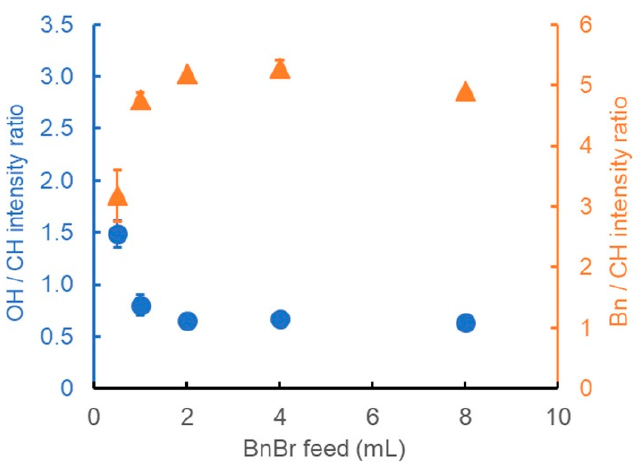
Figure 3. Ratio of the IR peak intensity derived from the OH groups (blue circles) or benzene rings (orange triangles) to that of CH stretching vibrations, showing the dependence of the degree of benzylation on the BnBr amount